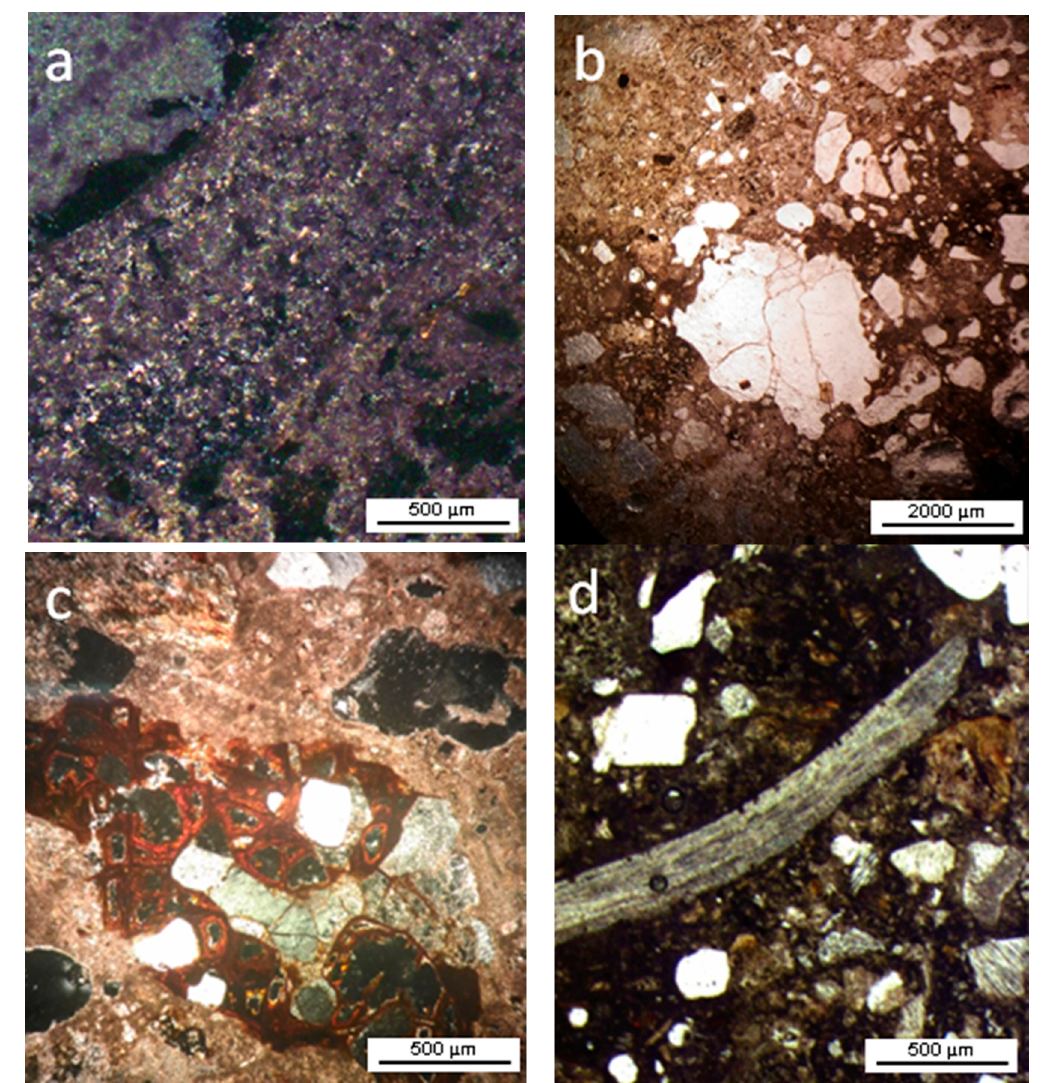
Figure 5. Microphotograph (transmitted light) of the S-001 mortar sample: ( a ) very thin matrix (10×, #), ( b ) matrix with two colors (2.5×, //), ( c ) ochre staining (10×, //), and ( d ) shell fragments (10×, //). #: parallel and //: perpendicular.